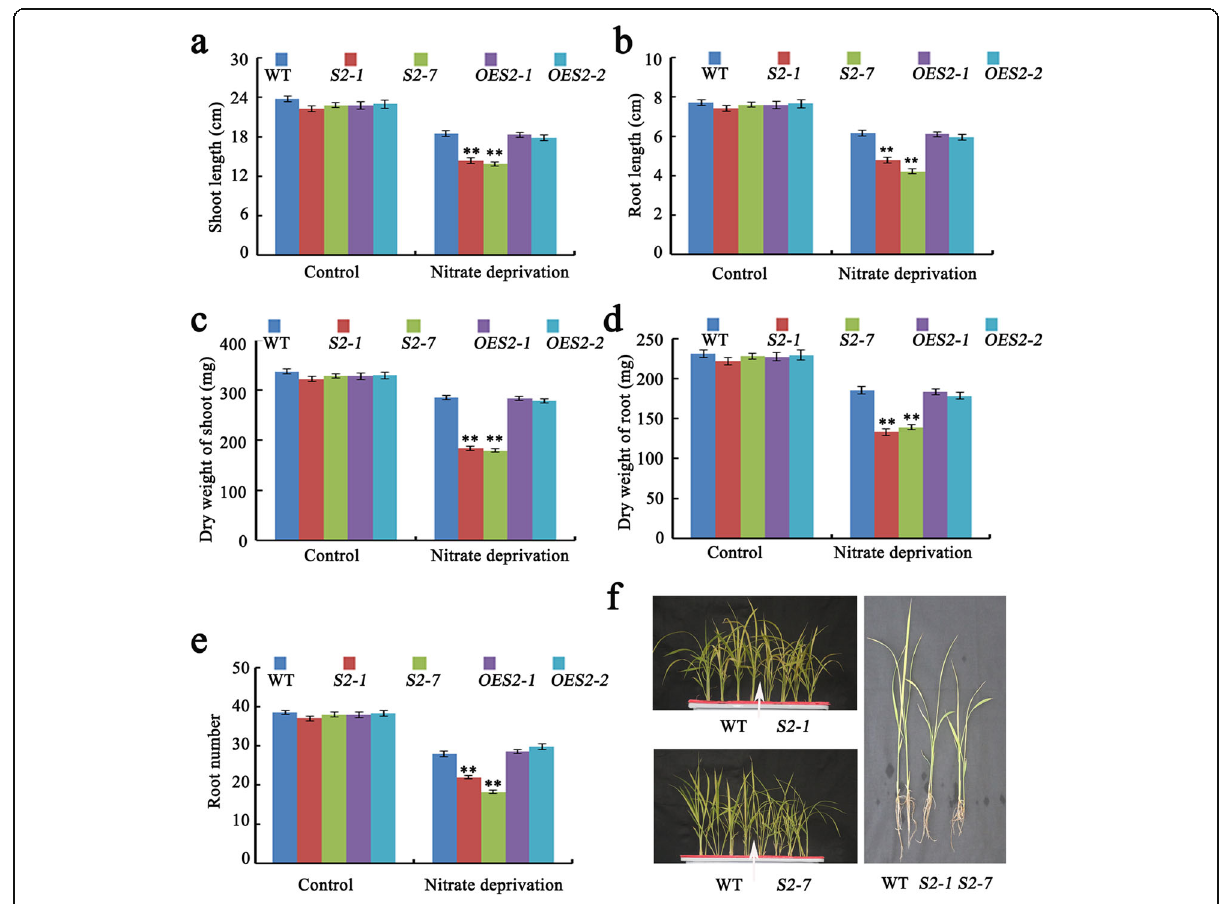
Fig. 4 SAPK2 affects seedling growth and root development under N deprivation. a-e Statistical analysis of shoot length ( a ), root length ( b ), dry weight of shoot ( c ), dry weight of root ( d ) and root number ( e ) among WT, sapk2 mutant lines and OE lines under N-deprived conditions. f Phenotypic analysis of seedlings at 31 DAG among WT, sapk2 mutant lines and OE lines under N-deprived conditions. Data in a-e are shown as means ± SD ( n = 20) from three replicates. A student ’ s t -test was used to generate P values; “ ** ” indicate significance at P <